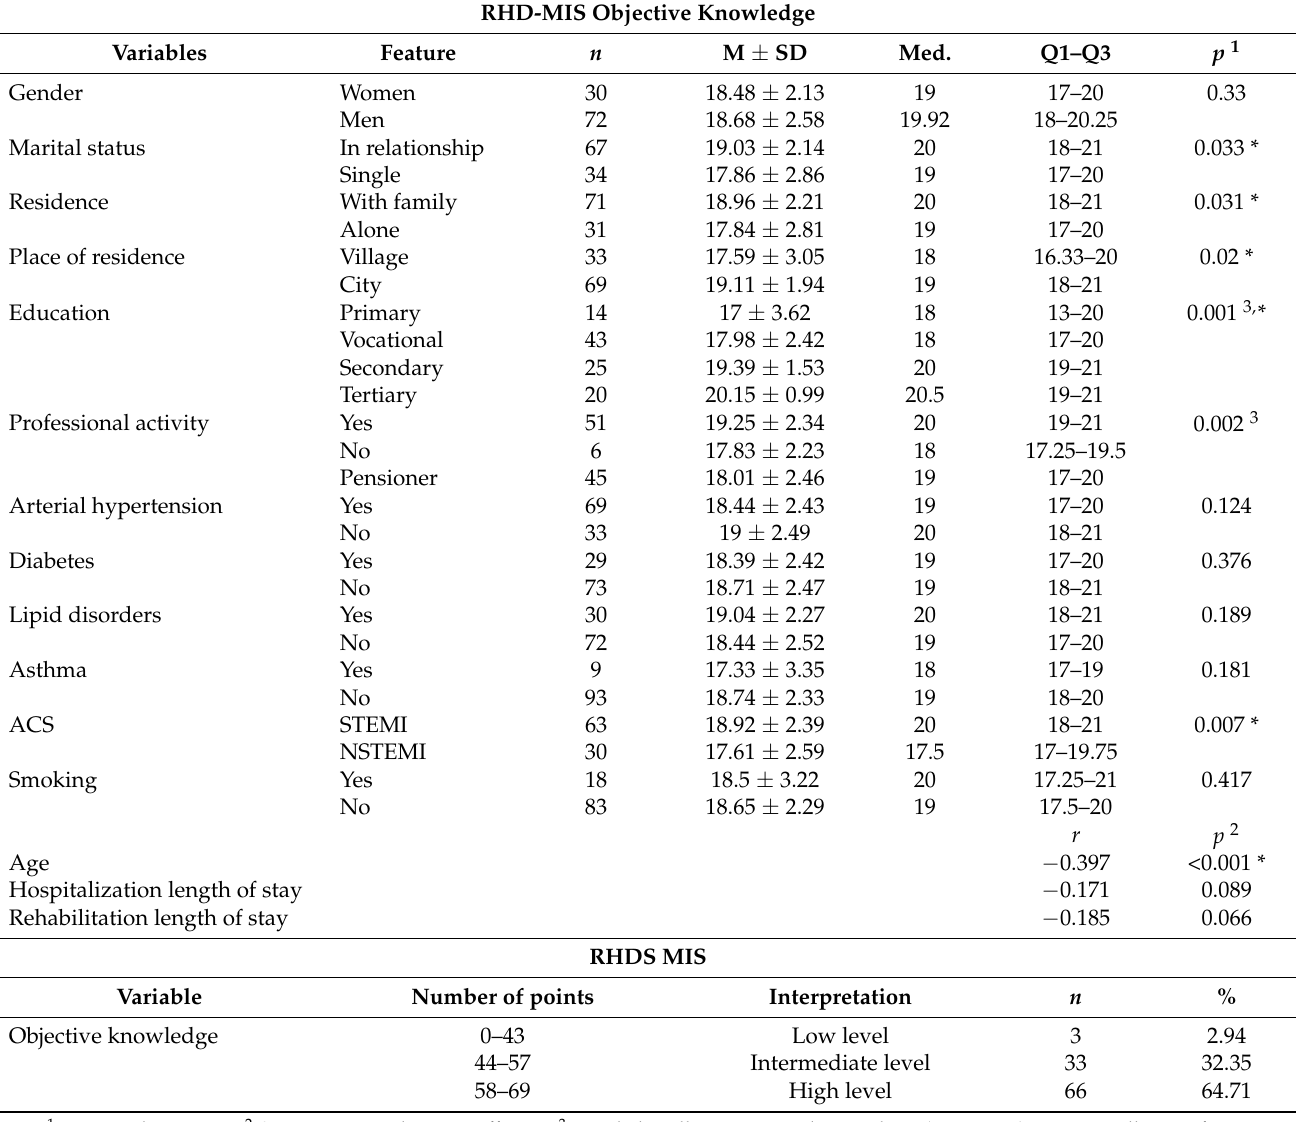
Table 4. Effects of socio-demographic and clinical variables on objective knowledge about the disease in MI